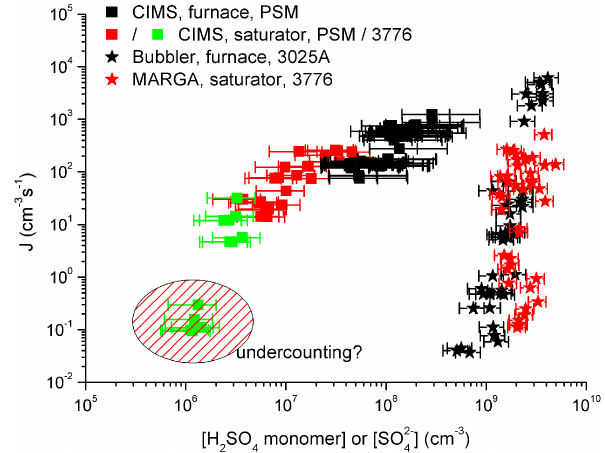
Figure 10. Comparison of formation rates J as a function of resid- ual sulfuric-acid monomer concentration [H 2 SO 4 ] or total-sulfate concentration [SO 2 − ] to our previous results. Conditions are sim- 4 ilar ( T = 298K, RH ∼ 30%). Note the factor-of-2 difference be- tween the residence times between furnace and saturator measure- ments. Sulfuric-acid vapor was previously produced with the fur- nace method and total-sulfate concentration measured with the bub- bler method (Brus et al.,